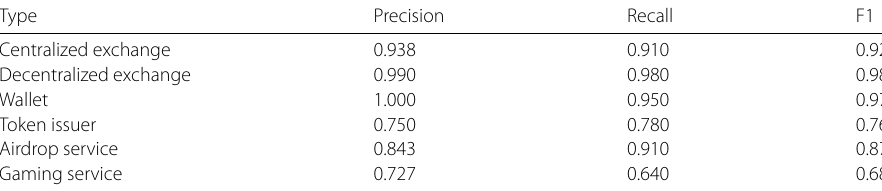
Table 4 The identifiability of each type of key agent using the random forest classifier Type Precision Recall F1 Centralized